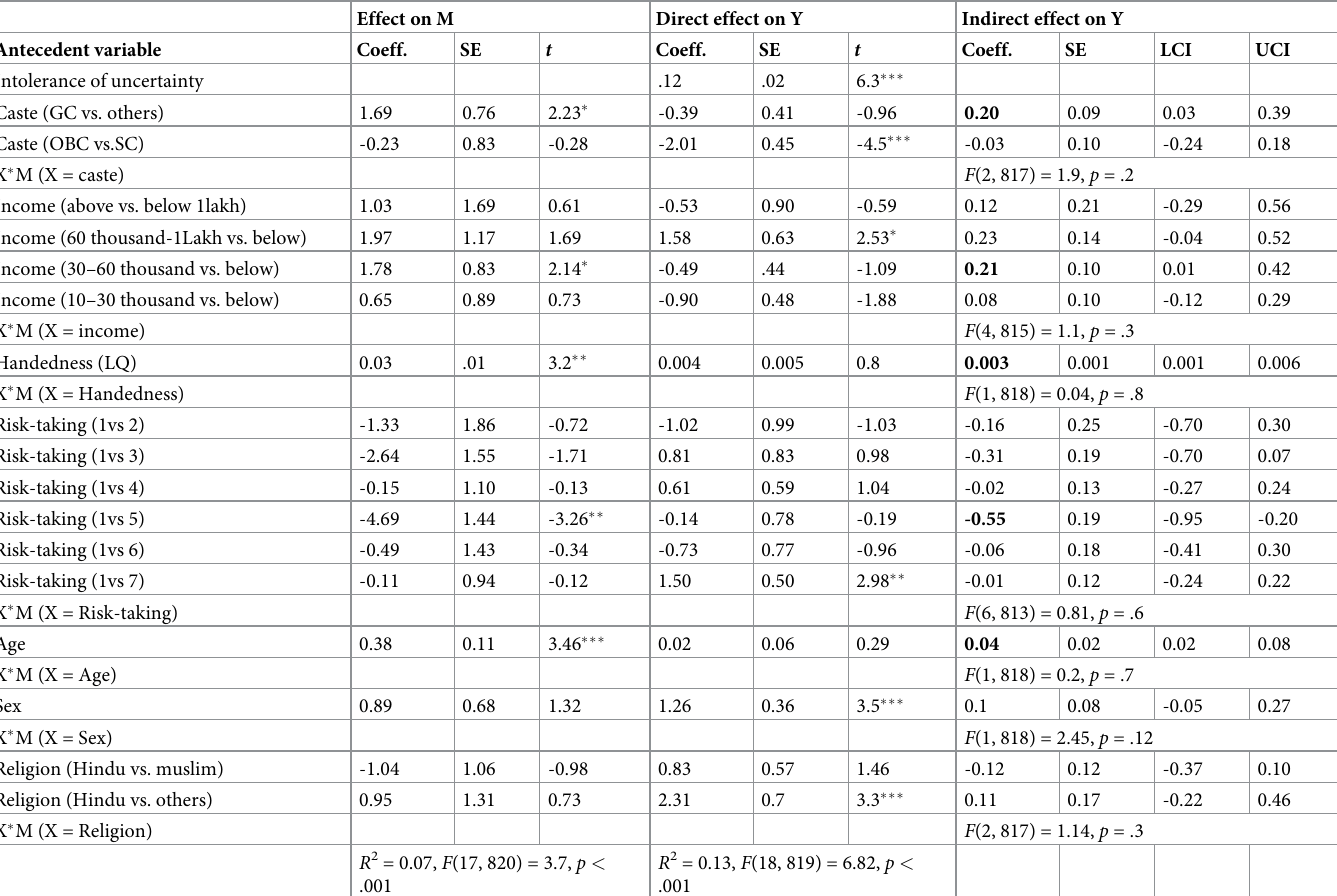
Table 5. The effects (direct and indirect effect) of antecedent and mediation (general IU) variables on bonding in the students’